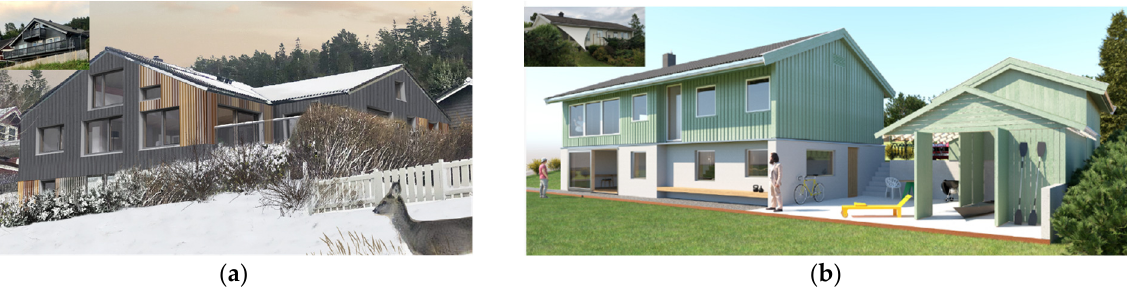
Figure 3. The two OPPTRE case studies [3]: ( a ) Malvik 1989 by Pir II; ( b ) Sandefjord 1972 by Hans Hus Arkitekter.